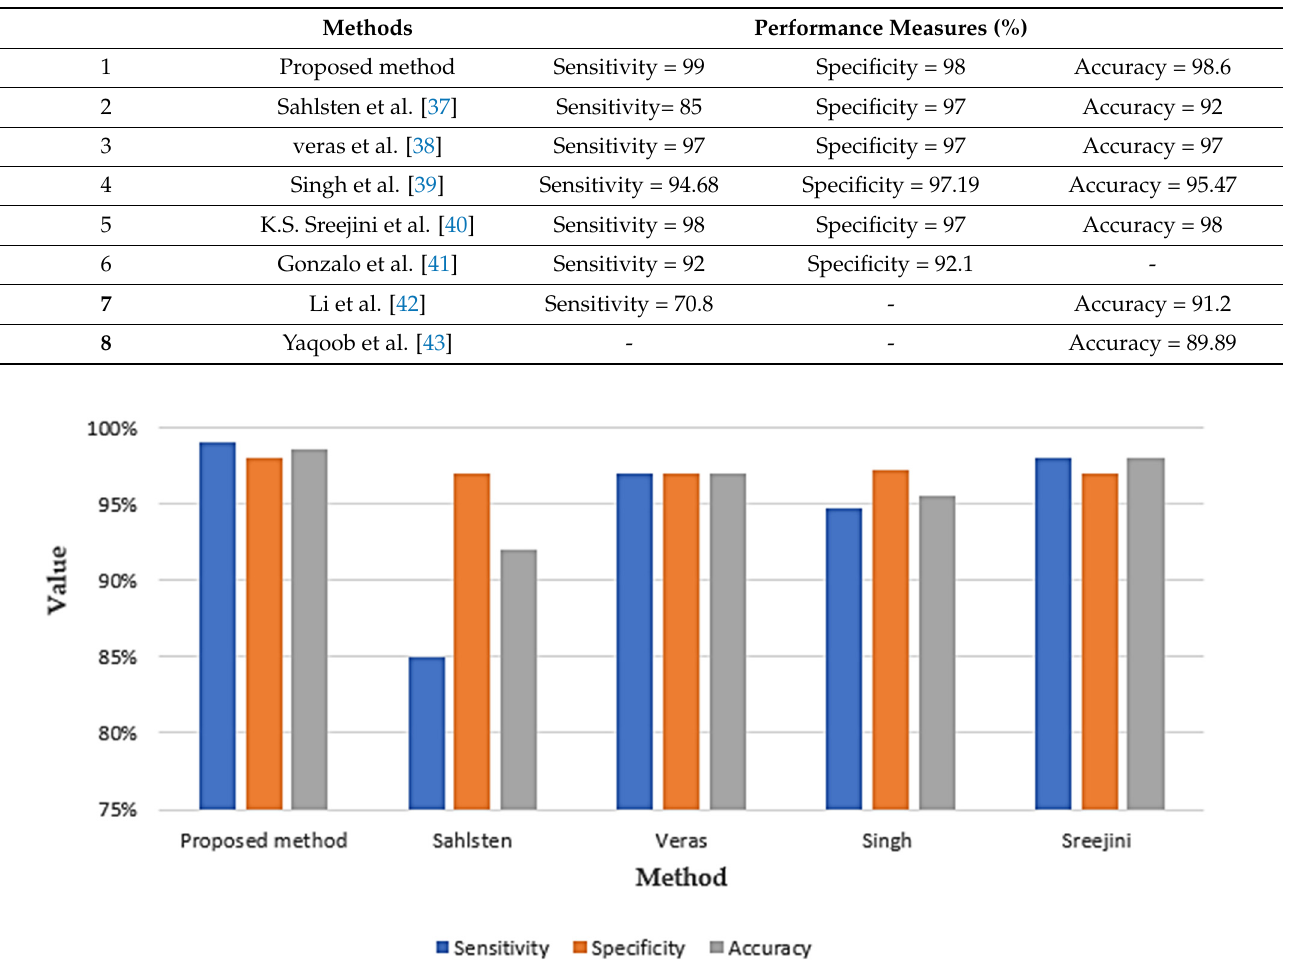
Figure 8. Results were obtained by comparing the presence of disease on the MESSIDOR database[37]–[40].